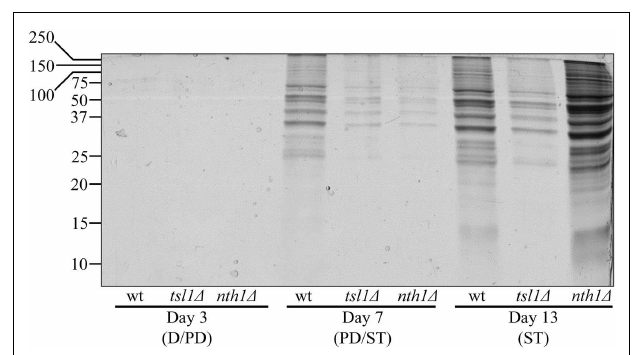
FIGURE 3 | In yeast grown under CR conditions, a pattern of age-related changes in trehalose concentration defines the dynamics of protein aggregation throughout lifespan. Total cell lysates were made by vortexing the cells in ice-cold buffer with glass beads. Unbroken cells and cell debris were removed by centrifugation for 3min at 1,000 × g at 4˚C.The supernatants of total cell lysates were collected and normalized by dilution to a final concentration of 1mg/ml. Equal aliquots of the total cell lysates were supplemented with CHAPS, a zwitterionic, non-denaturing, and electrically neutral detergent that protects a native state of soluble proteins and efficiently solubilizes membrane proteins, but is unable to solubilize aggregates of denatured proteins. After incubation on ice for 30min, samples were subjected to centrifugation at 100,000 × g for 30min at 4˚C.The pellet fractions of insoluble aggregates of denatured proteins were analyzed by 12.5% SDS-PAGE, followed by silver staining. wt, tsl1 ∆ and nth1 ∆ cells were cultured inYP medium initially containing 0.2% glucose. Abbreviations: D, diauxic growth phase; PD, post-diauxic growth phase; ST, stationary growth